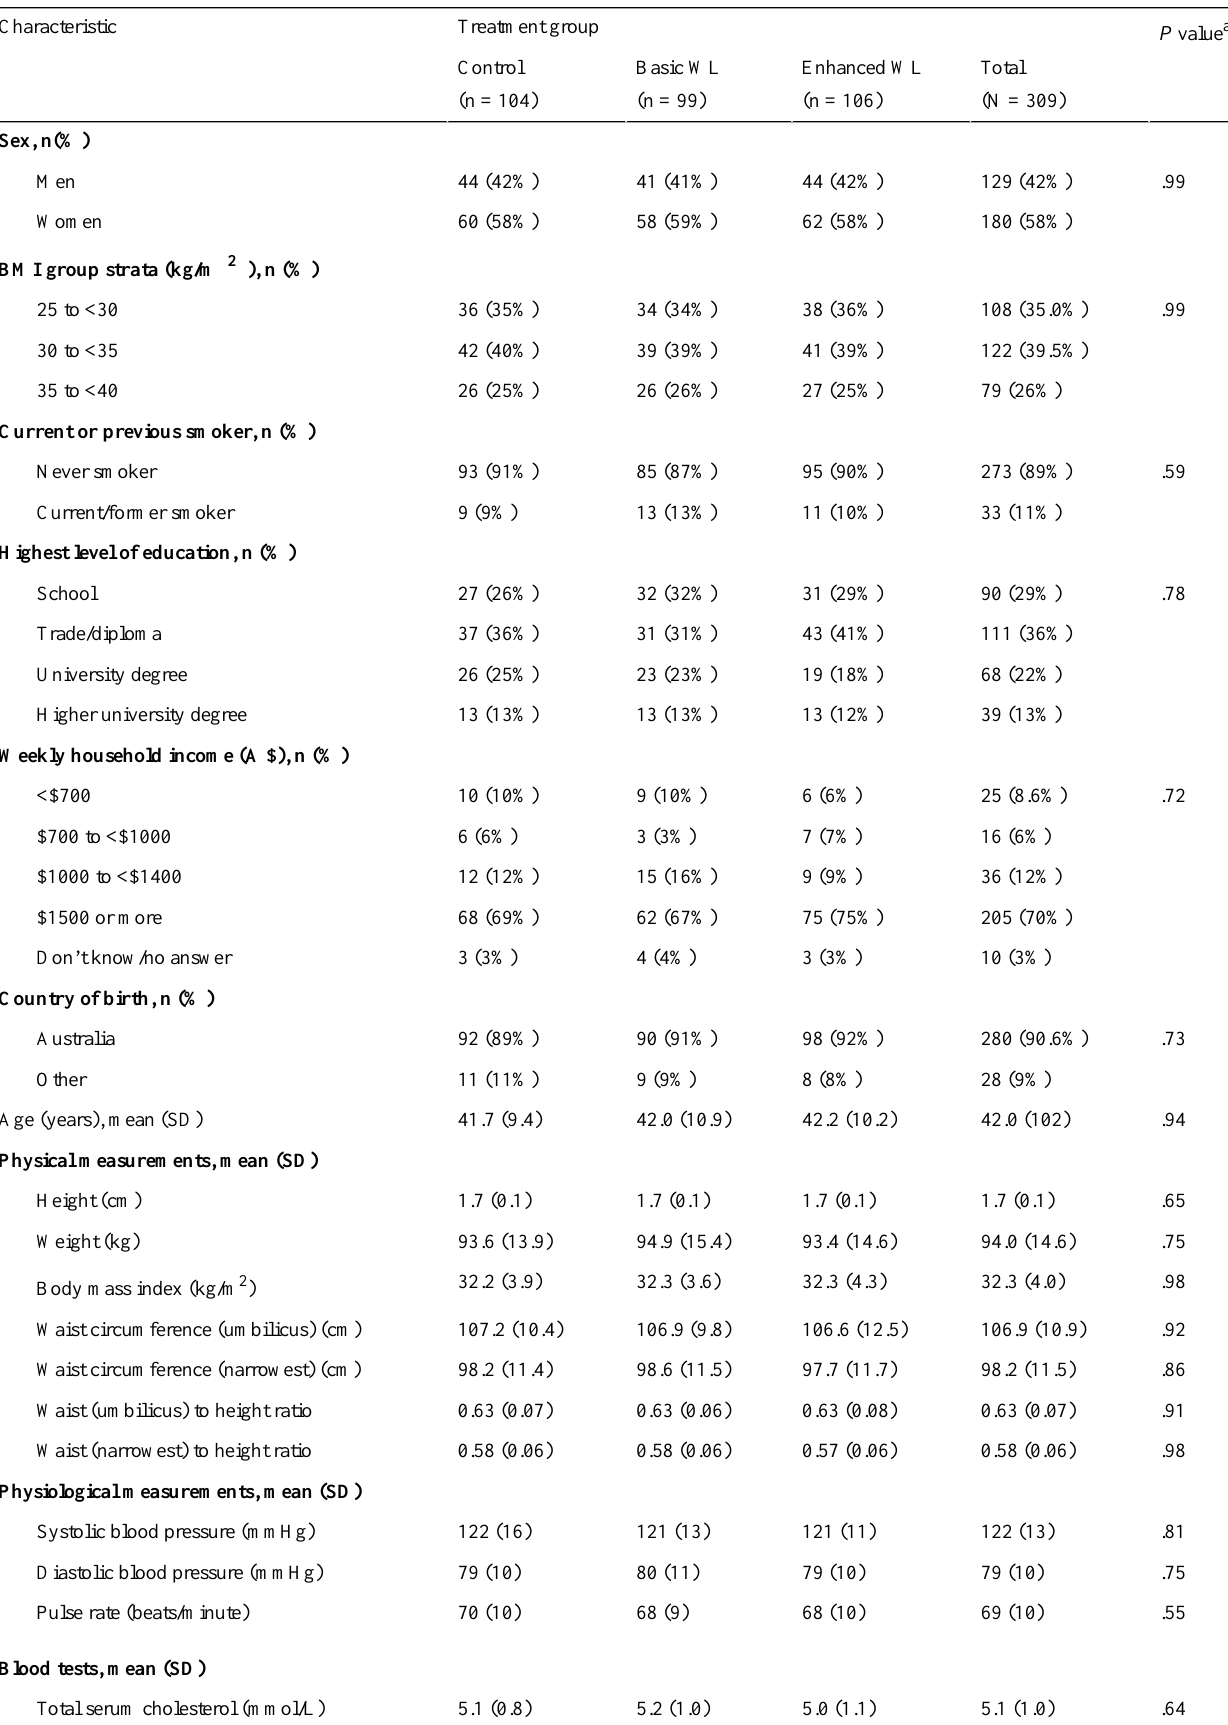
Table 1. Baseline characteristics of participants in a 12-week Web-based weight-loss (WL) program by intervention